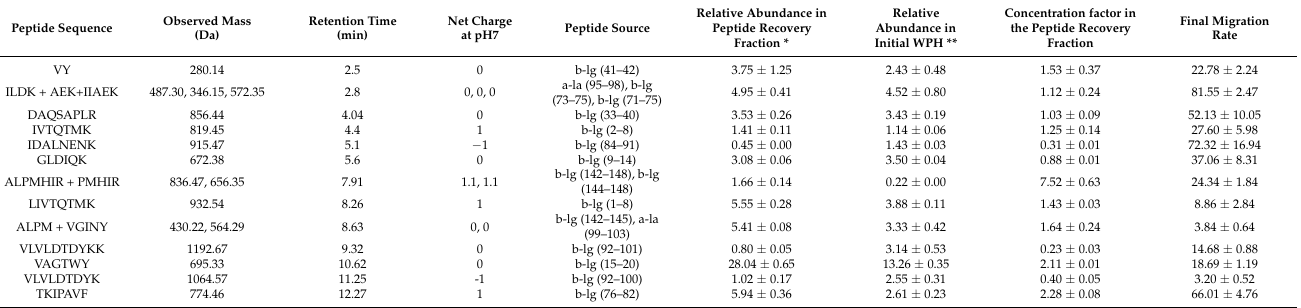
Table 1. Major components recovered in the peptide recovery fraction: characteristics, relative abundance (in%), concentration factor (in X) and final migration rate (in